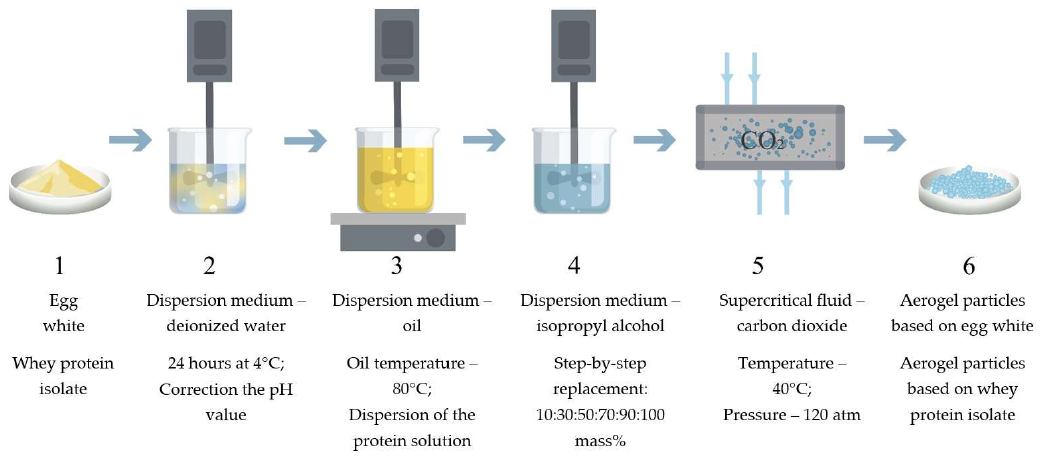
Figure 8. Scheme of the synthesis of protein aerogel particles: ( 1 ) initial protein; ( 2 ) obtaining protein solution; ( 3 ) dispersion and gelation; ( 4 ) oil washing and solvent replacement; ( 5 ) supercritical drying; ( 6 ) protein aerogel particles.